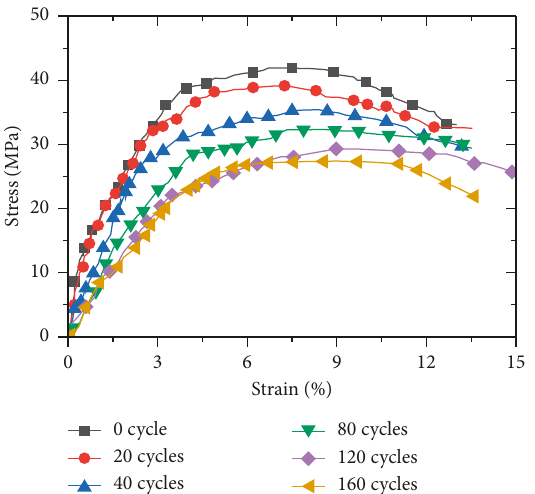
Figure 4: The relationship between stress and strain (NaCl solu- tion, i.e., SE1